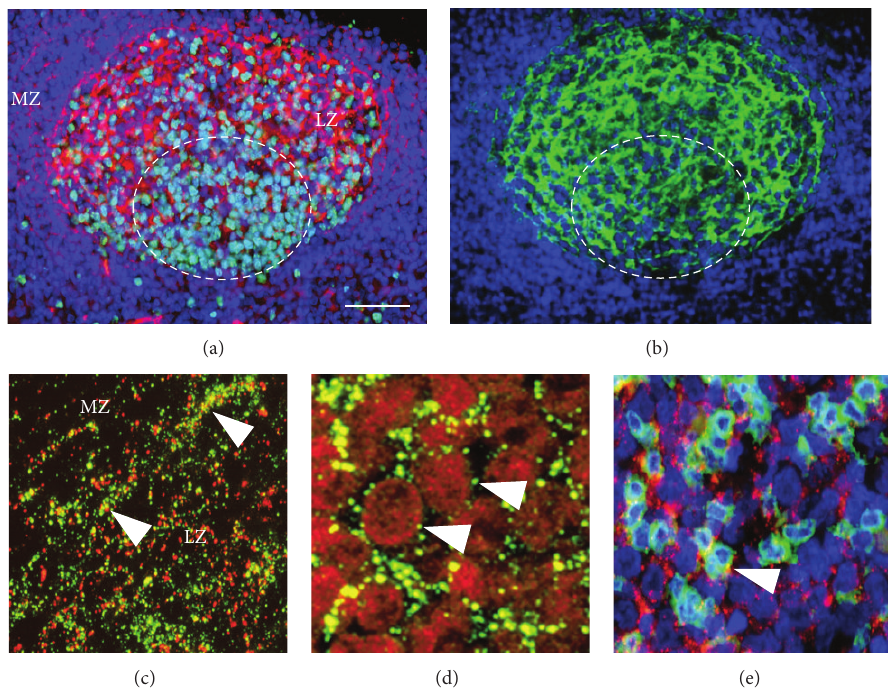
Figure 1: Connexin 43 expression in secondary lymphoid follicles of reactive human tonsils. Cx43 immunoreaction (red) is accumulated mainly in the light zone localizing less Ki67 positive lymphocytes ((a), green) and more CD21 positive FDC processes ((b), green) than the dark zone (circled areas) of germinal center in consecutive sections. Cx43 (green) colocalizes with desmoplakin (red) produced by FDC ((c); arrowheads). Cx43 plaques (green) are also closely associated with B cells ((d); arrowheads) and rarely with CD4 positive T cells ((e); Cx43: red, CD4: green, arrowhead) in the germinal center. Immunofluorescence, nuclear staining in (a), (b), and (e) with Hoescht (blue) and in (d) with 7-aminoactinomycin D (red). LZ: light zone and MZ: mantle zone. Scale bar on (a) shows 30 𝜇 m on (a) and (b); 15 𝜇 m on (c) and (e); and 7 𝜇 m on